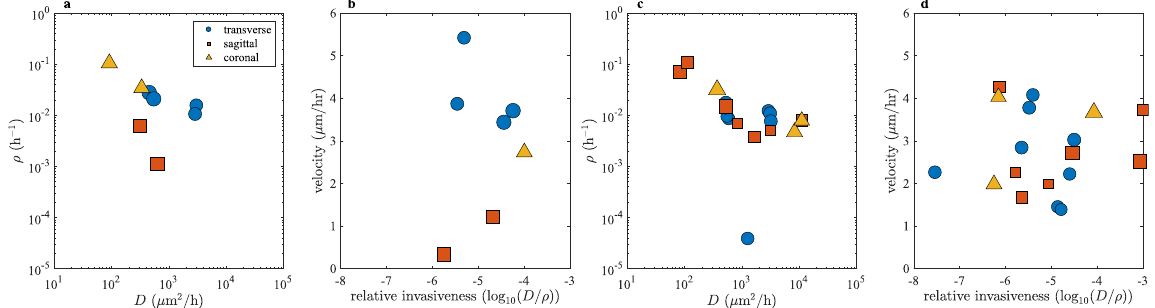
Figure 6. Parameter values for Mouse 1 and 2 from the 2D level set method. Estimated parameter values for various 2D slices as reported in Table 4: ( a ) Mouse 1 and ( c ) Mouse 2. The parameter estimation routine was run for various initial parameter value guesses, and the size of the data points corresponds to the magnitude of the error in equation (8). Radial velocity of the tumor taken from the last simulated day of movement versus relative invasiveness: ( b ) Mouse 1 and ( d ) Mouse 2.